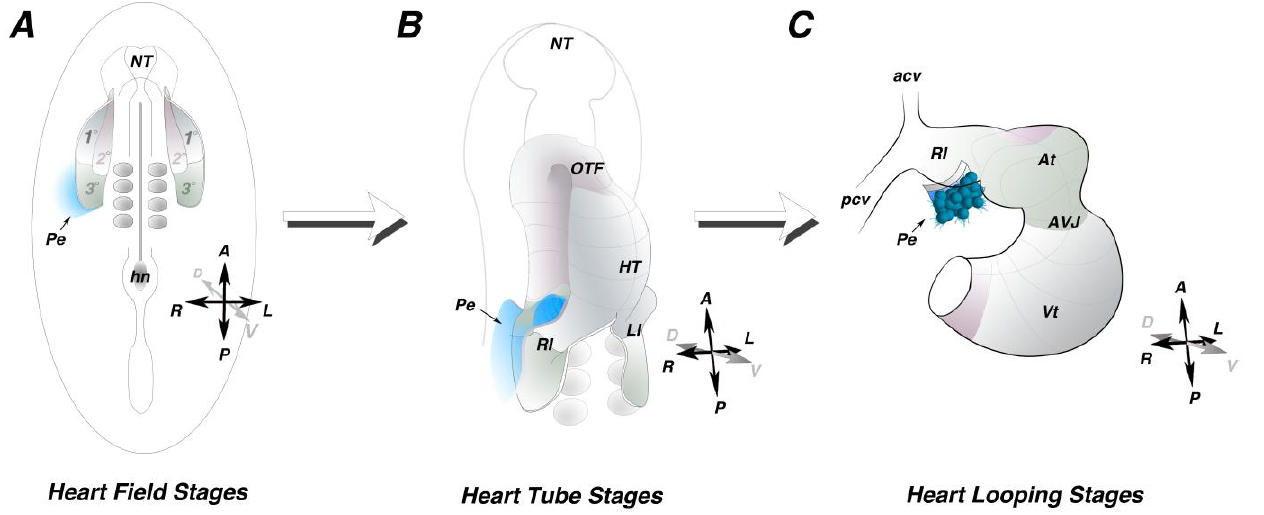
Figure 1. Proepicardial field. ( A ) Schematic of an early somite stage chick embryo. Heart precursors occupy bilateral fields within the lateral plate mesoderm. The primary heart field (1°) is indicated in grey, the secondary heart field (2°) is indicated in pink and the posterior tertiary heart field (3°) is indicated in green. Fate mapping studies indicate the progenitors of the proepicardium reside outside and adjacent to the tertiary heart field (blue). ( B ) Schematic of a heart tube. The primary heart fields have fused along the midline, while the secondary and tertiary heart field have not yet been incorporated into the heart. The proepicardial precursors maintain their position lateral to the heart field mesoderm (blue). ( C ) Schematic of a looping stage heart. The proepicardium (blue) can be seen extending off the right inflow of the heart. HT (cid:178) heart tube; At (cid:178) atria; AVJ (cid:178) atrioventricular junction; Vt (cid:178) ventricle, Pe (cid:178) proepicardium; A (cid:178) anterior; P (cid:178) posterior; R (cid:178) right; L (cid:178) Left; D (cid:178) dorsal; V (cid:178)